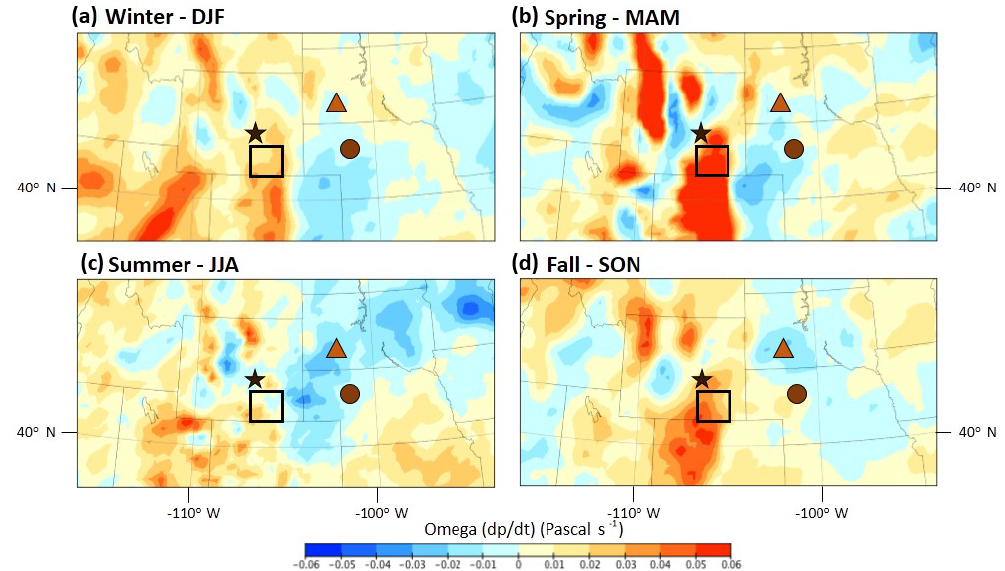
Figure 9. Composite-anomaly maps for 500mbar omega (vertical velocity) during (a) winter (DJF); (b) spring (MAM); (c) summer (JJA); and (d) the fall (SON). Positive values (warm colours) for omega indicate enhanced sinking motions (suppress precipitation). Negative values (cool colours) indicate enhanced rising motions (enhanced precipitation). The black box denotes the study site, Long Lake in the Medicine Bow Mountains of southeastern, Wyoming. The black star denotes the Ferris and Casper dune fields; the orange triangle denotes the White River Badlands dunes; and the brown circle denotes the Nebraska Hills sand